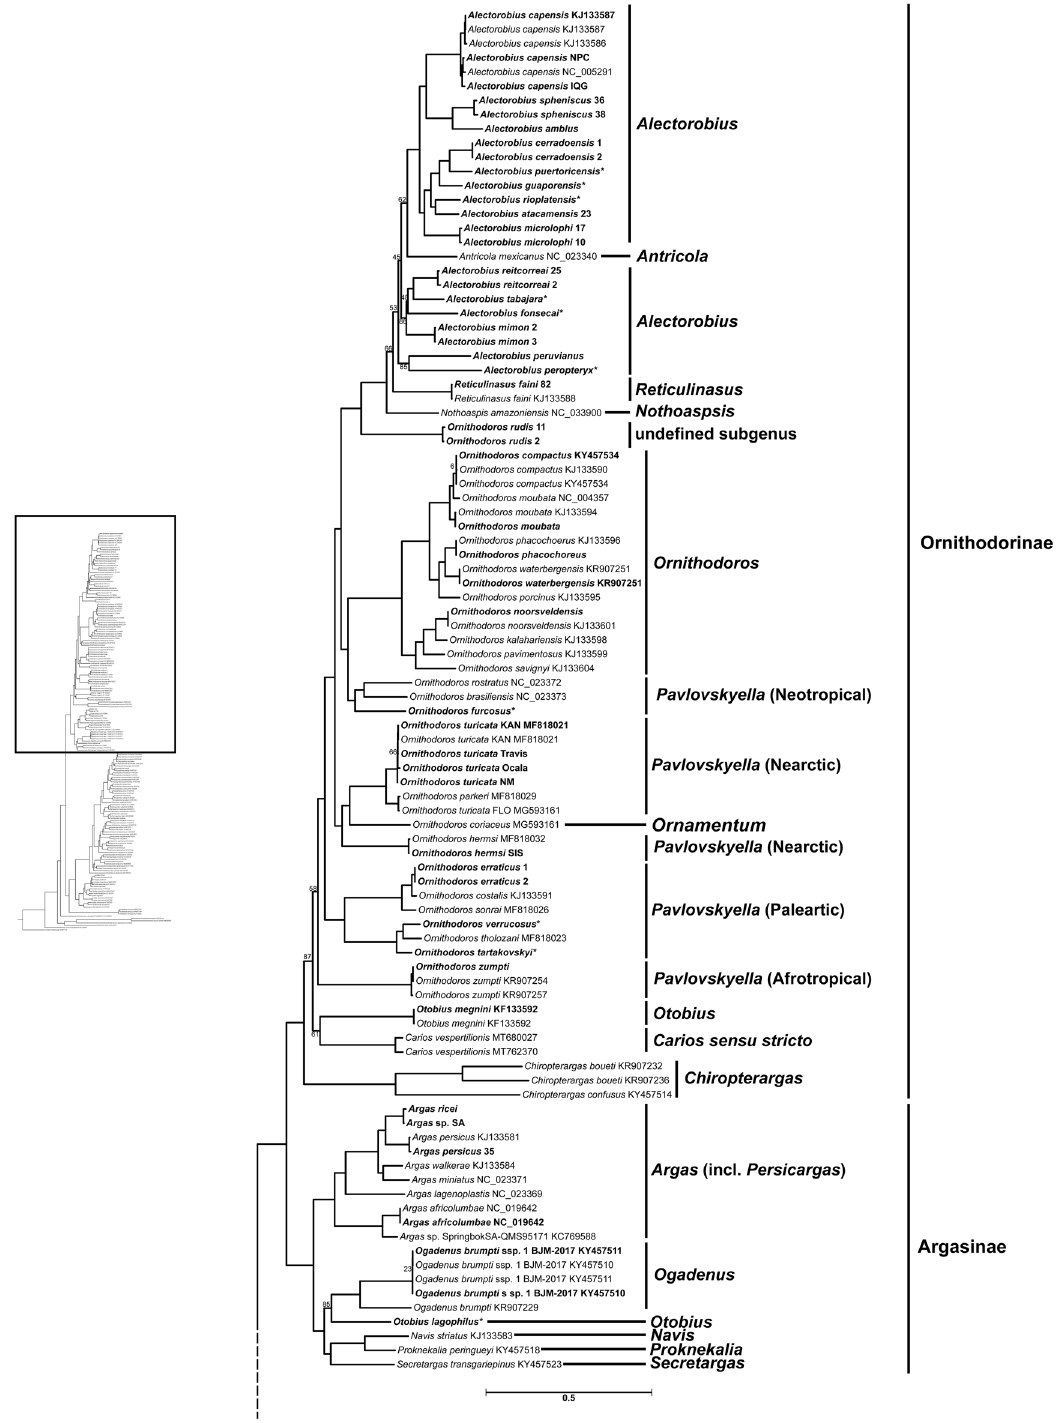
Figure 4. Argasidae phylogeny. The Argasidae portion of the maximum likelihood inferred phylogeny using the 10AA scheme from Kelava et al . 12 for the Argasidae, Nuttalliellidae, and Ixodidae is shown here. Ultra-fast bootstrap support is reported on branches as the percentage of 100,000 replicates, those with < 90% support are shown. Tip labels that contain an asterisk (*) indicate that there were multiple samples of the same species, from the same locality, whose sequence alignment was 100% the same. GenBank accession numbers are located at the end of tip labels. Tip labels that are bolded indicate samples that were sequenced in this study and those that are bolded with GenBank accession numbers were a part of the benchmarking cohort. The subgenus that the tips correspond with are indicated to the right. The subfamilies are indicated to the right of the subgenus. The scale bar indicates number of substitutions per site. We include a phylogeny to the left to orient the reader to which part of the total tick phylogeny they are viewing. The dotted branch indicates where this portion of the phylogeny meets the rest of the